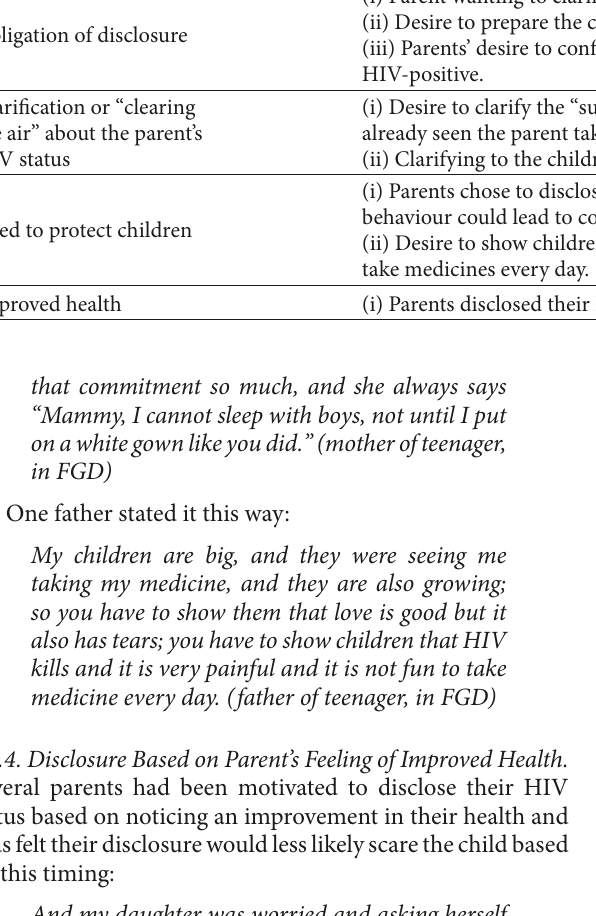
Table 3: Motivators to disclosure, as presented by parents who disclosed their HIV status to their children.